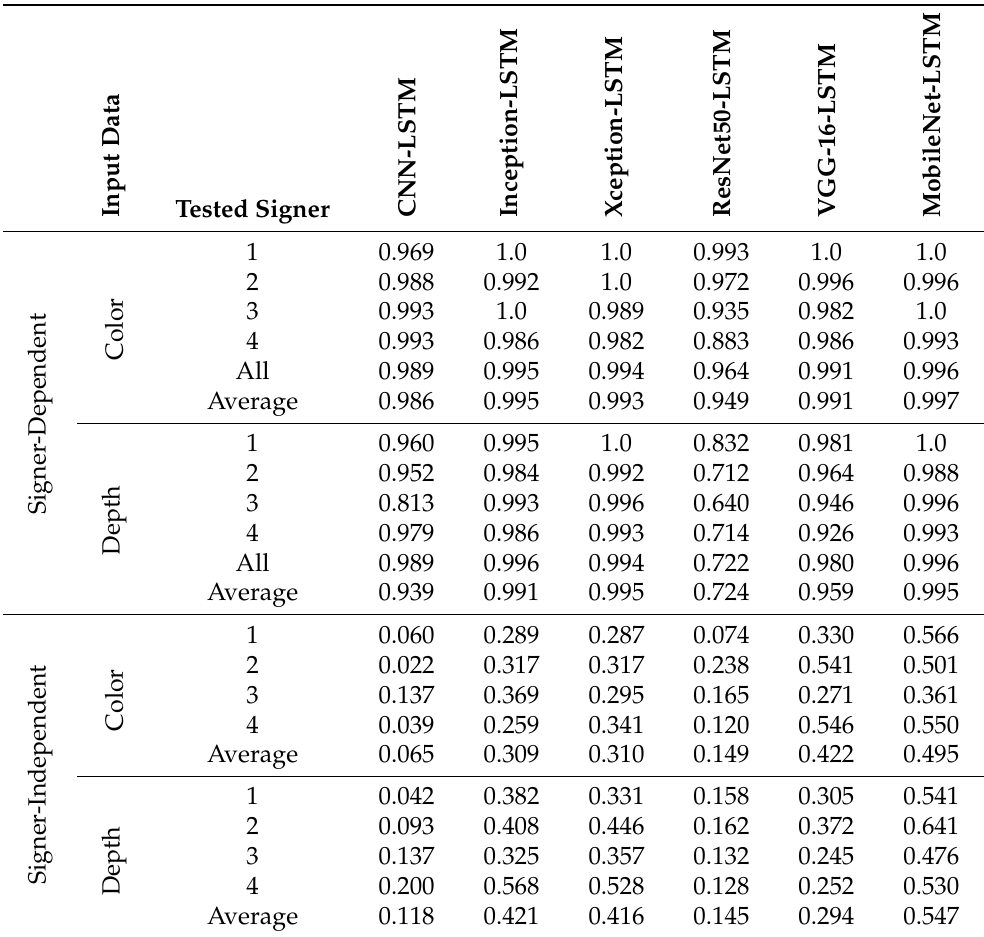
Table 3. Recognition accuracies using color and depth